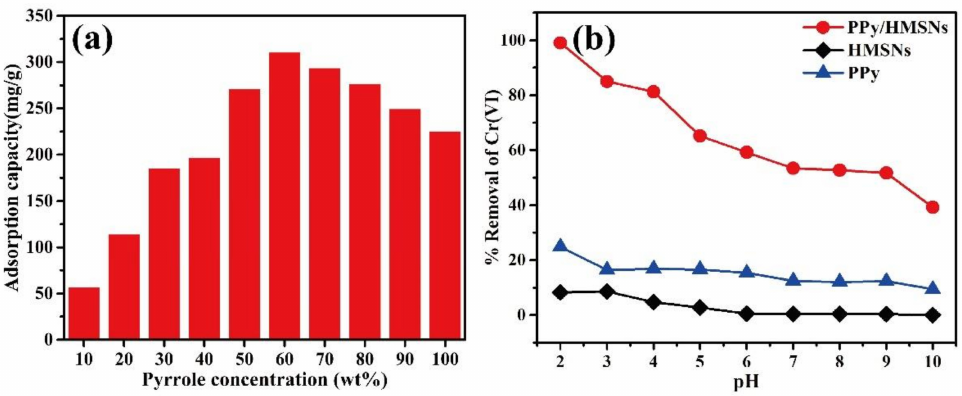
Figure 3. The e ff ect ( a ) of PPy / HMSNs prepared at di ff erent pyrrole concentrations on the adsorption capacity of Cr(VI), and the removal rate ( b ) of Cr(VI) by PPy, HMSNs, and PPy / HMSNs at di ff erent